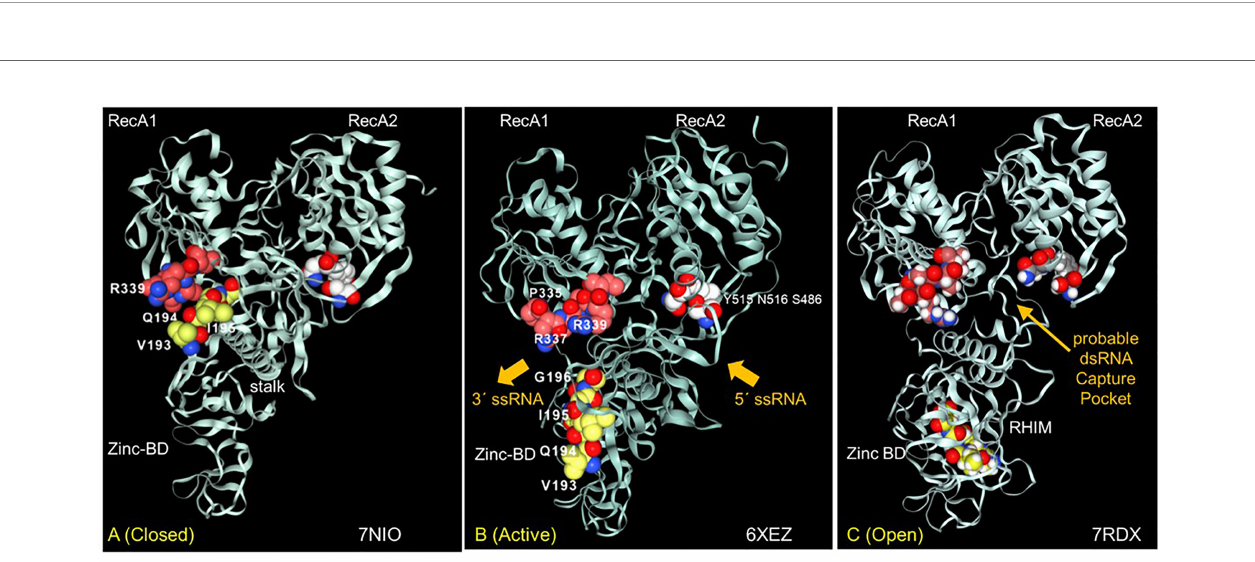
FIGURE 5 | The interaction between the Nsp13 RHIM (residues 193-6) and PARAR (residues 335-9) are conformation dependent. (A) In the ATP-free apo form of Nsp13, the RHIM (yellow space fi ll carbons) contacts PARAR (crimson space fi ll carbons) (B) In the active state, RHIM and PARAR separate, opening the 5´ end of the single-strand RNA channel, that has the 3´end marked by N516 (white space fi ll carbons). (C) In the open complex, the RHIM separates further from the RecA2 domains to create a cavity that is potentially large enough to accommodate dsRNA. This opening is associated with a rotation of the Zinc binding domain (ZincBD) relative to N516. PARAR also rotates, changing the position of R337 and R339. The structures are from PDB fi les 7NIO (44), 6XEZ (45) and 7RDX (46) as labeled, with images rendered using the NGLViewer